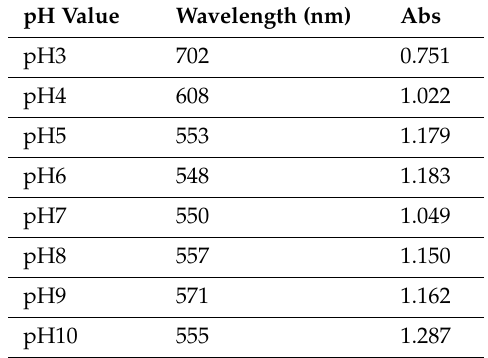
Figure 4. UV-Vis adsorption spectra of branched AuNPs synthesized by gelatin at various pH value: Table 3. UV-Vis results of branched gold nanoparticles (AuNPs) synthesized by gelatin at various pH